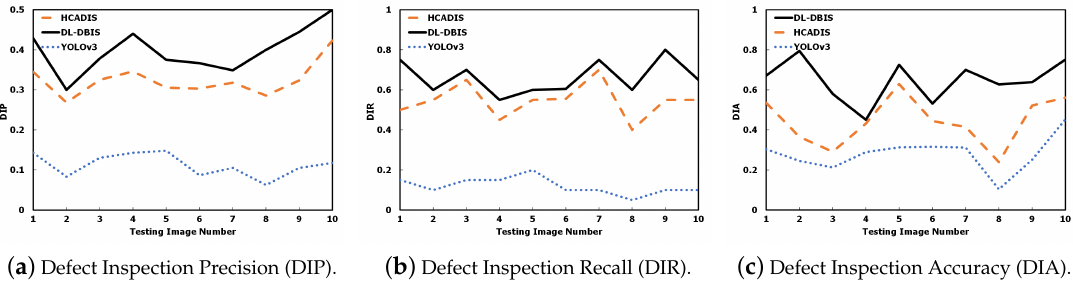
Figure 15. Performance study of the DIDN to ten randomly selected bean